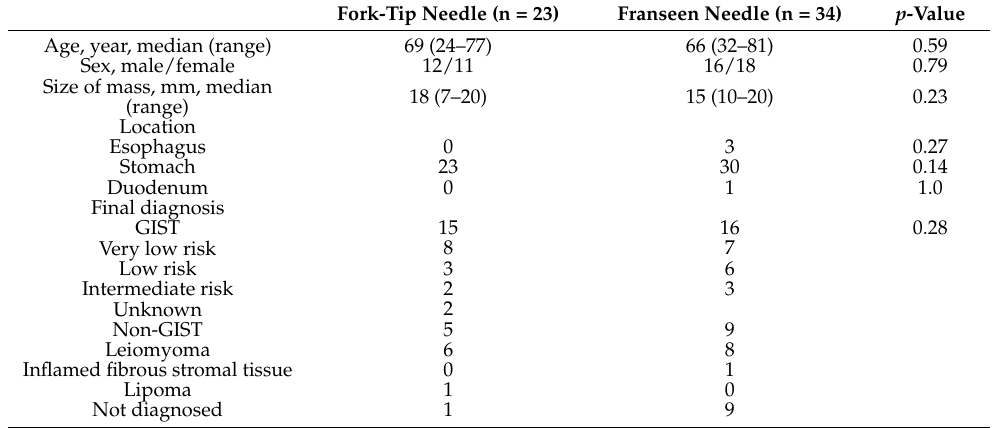
Table 1. Baseline Patient Characteristics.